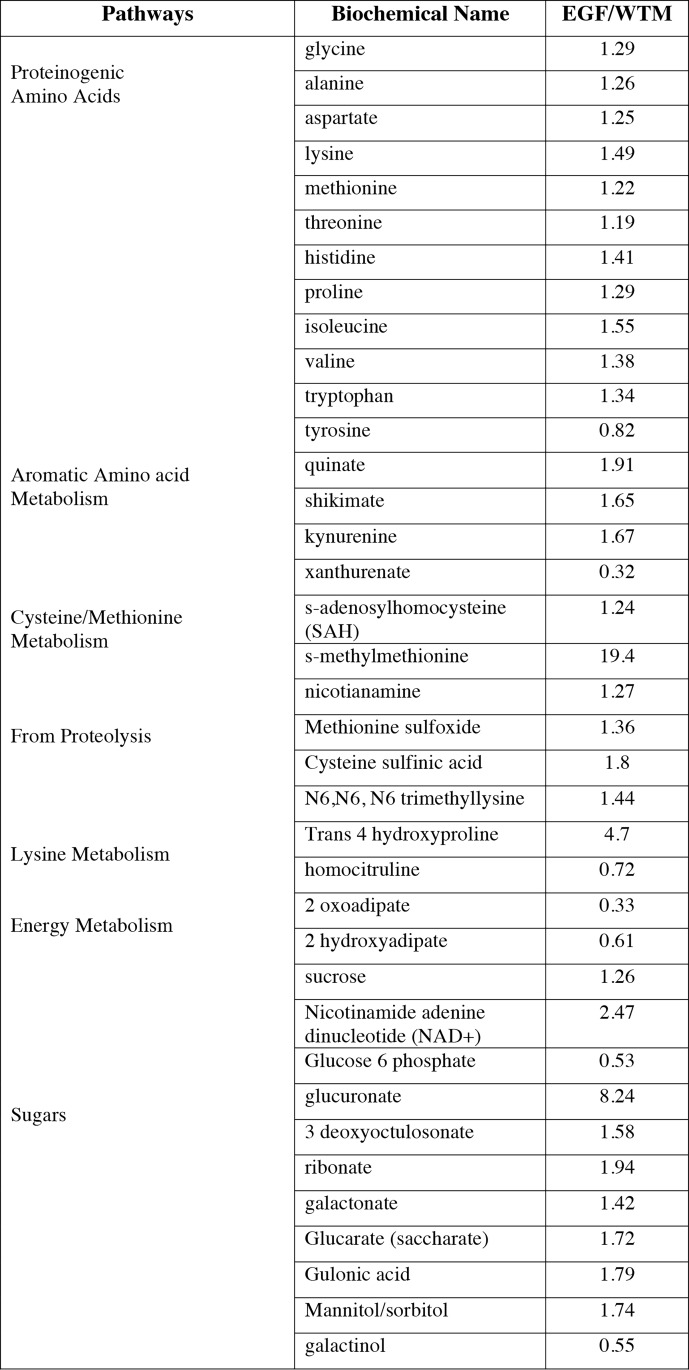
Relative proportion of non-targeted metabolites detected in soybean seeds shown as amount in EGF transgenic compared to nontransgenic (Wt).Complete list of non targeted metabolites quantitated in samples in S1 Table.